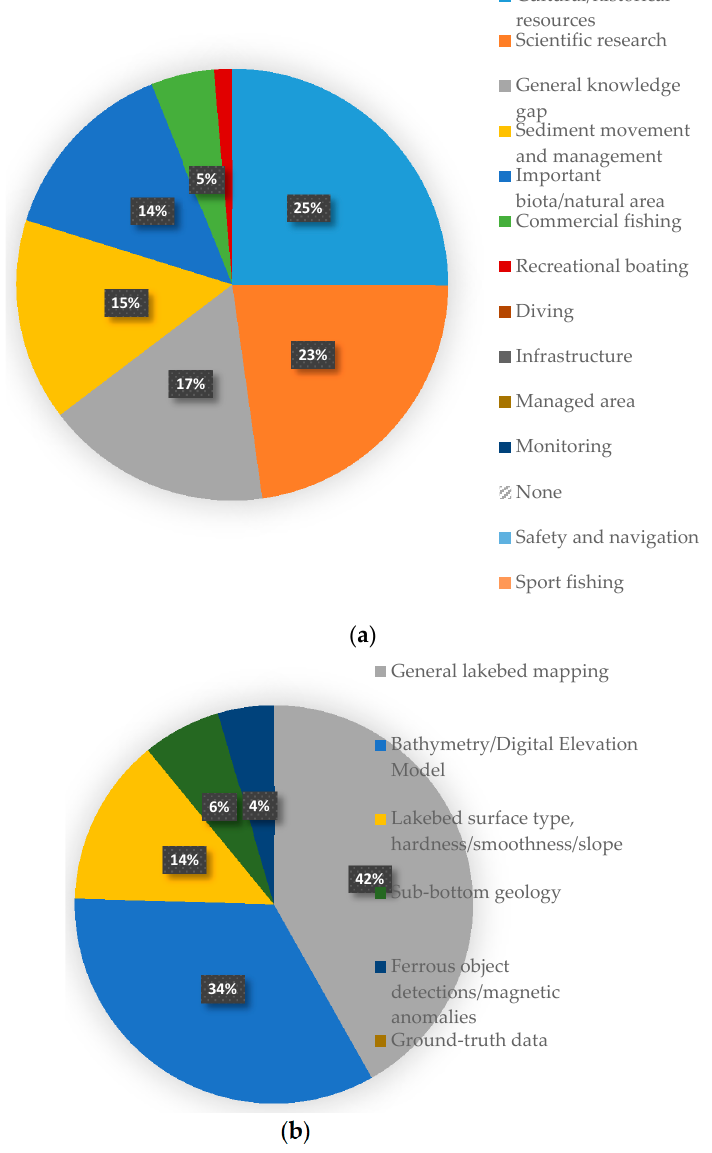
Figure 2. The primary ( a ) Justifications and ( b ) Map Products associated with coin attributes by proportion. Pie charts for secondary and tertiary levels are not shown for brevity, due to similarity to results for primary selections. Percentages <4% are not listed.